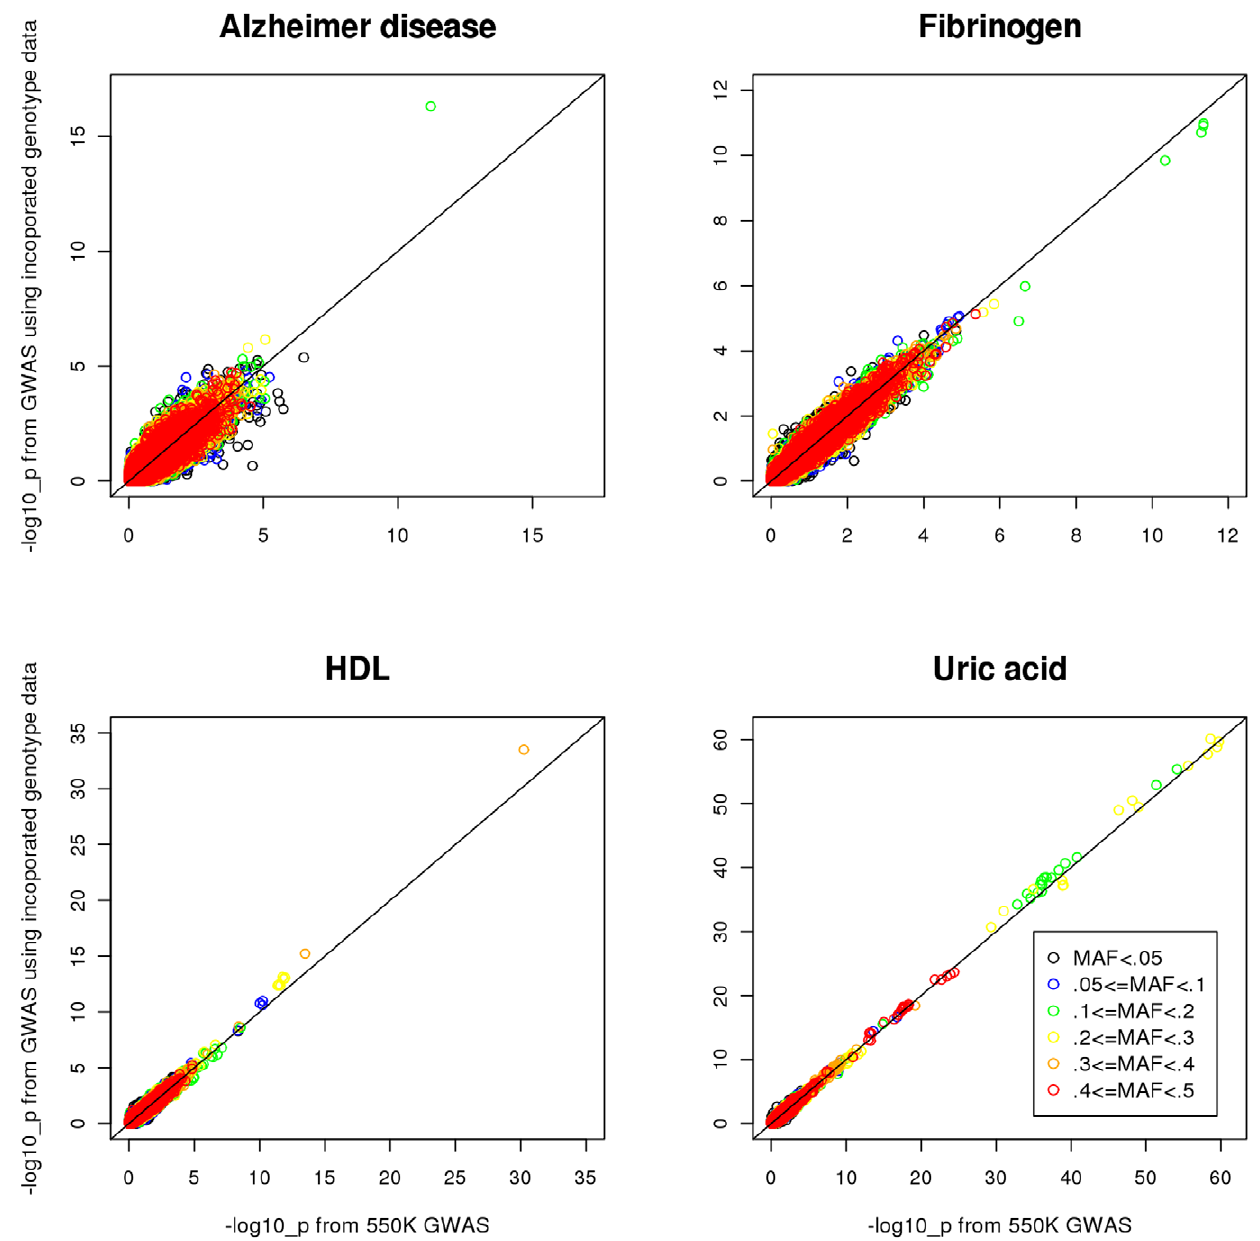
Figure 4. Scatter plots of –log 10 (p-value) from 550K GWAS and GWAS using incorporated genotype data.